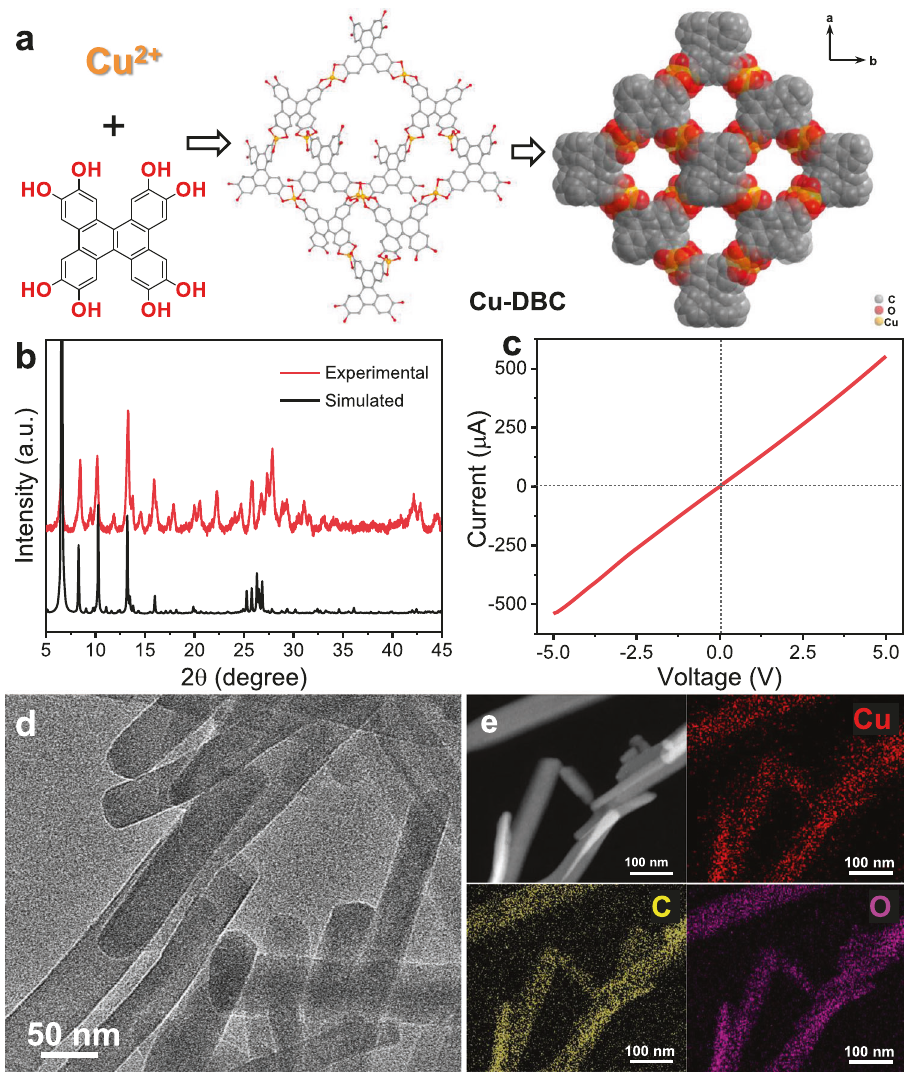
Fig. 1 Characterizations of Cu-DBC electrocatalyst. a The structure obtained by Cu ions and 8OH-DBC. b Simulated and experimental PXRD patterns. c Current – voltage characteristic using four-contact probe method. d TEM image. e STEM image and corresponding element mapping images of Cu, C, and